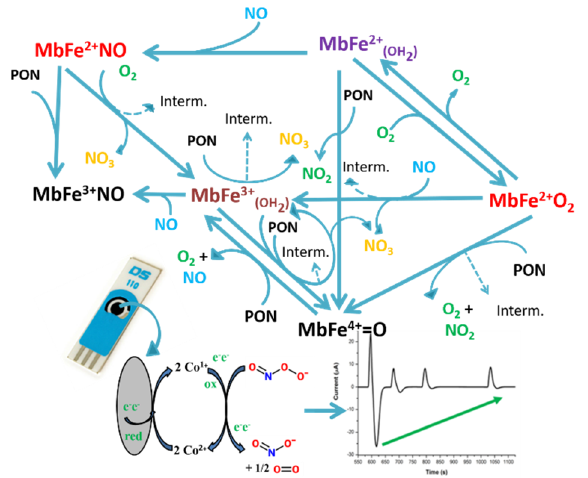
Figure 1. Graphical abstract. ferrylmyoglobin: MbFe 4+ = O, oxymyoglobin: MbFe 2+ O 2 , deoxymyoglobin: MbFe 2+ (OH 2 ), metmyoglobin: MbFe 3+ (OH 2 ), nitrosylmetmyoglobin: MbFe 3+ NO, nitrosylmyoglobin: MbFe 2+ NO. This is a schematic representation of the chemical reactions of different forms of myoglobin with peroxynitrite and other interfering species/decomposition products. This scheme is not exhaustive and was inspired from data from different literature references [2,21–26] .